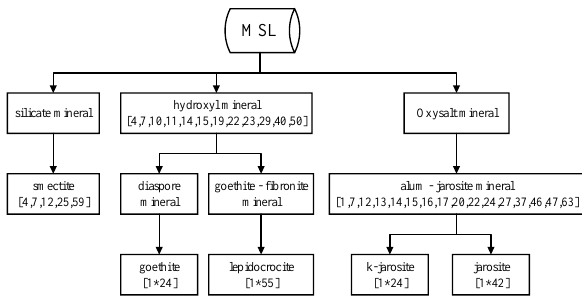
Figure 7. The decision tree of the experimental